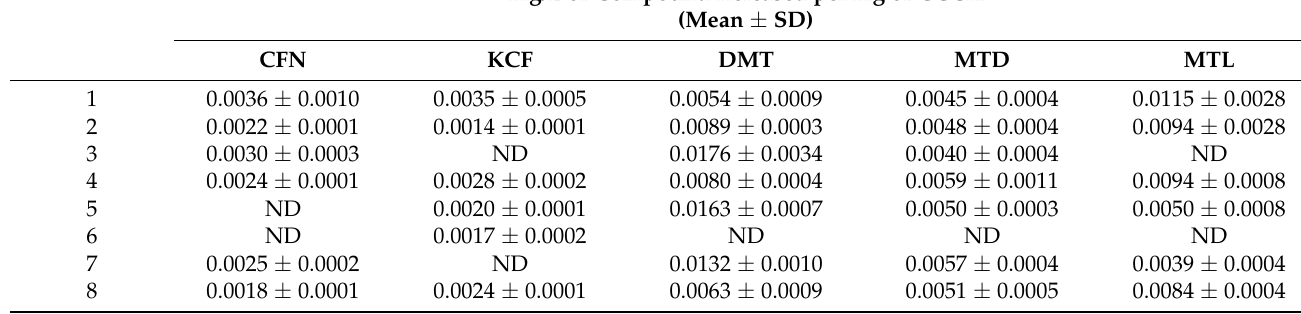
Table 8. Results of desorption tests of the compounds under study in selected optimal experimental conditions in urine, for the different sorbent materials